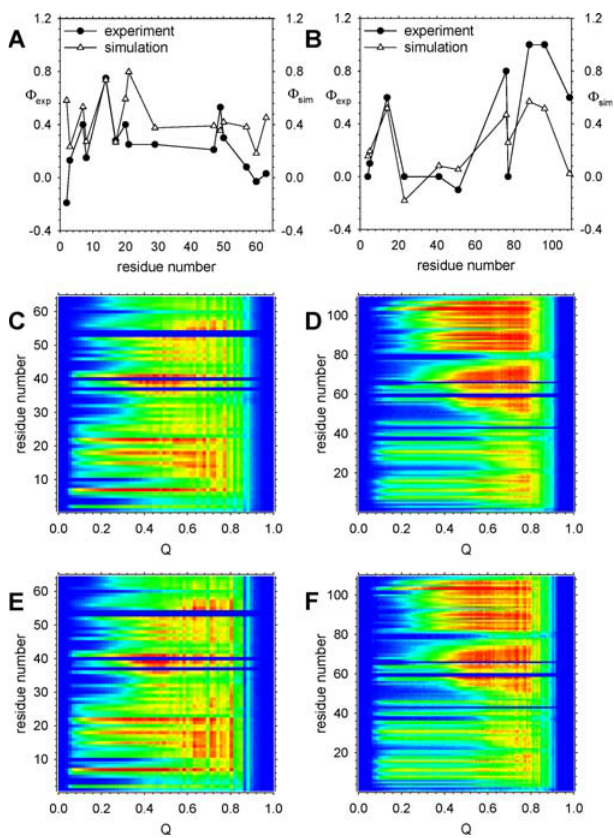
Figure 7. Simulated Mechanisms of Refolding and De Novo Folding for CI2 and Barnase (A) Comparison of computed and experimental U values for CI2. (B) Same as (A), but for for barnase. (C) Plot of Q res versus Q for refolding of CI2. (D) Same as (C), but for refolding of barnase. (E) Same as (C), but for the post-synthesis stage of de novo folding of CI2. (F) Same as (C), but for the post-synthesis stage of de novo folding of barnase. In panels (C–F), Q res values are shown on a continuous color scale between 0.0 (blue) and 0.75 (red) for CI2, and between 0.0 (blue) and 0.9 (red) for barnase. DOI: